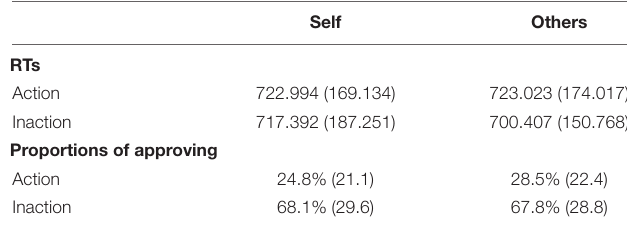
TABLE 1 | Mean RTs (ms) and the proportions of approving (%) (standard deviation) in each condition.